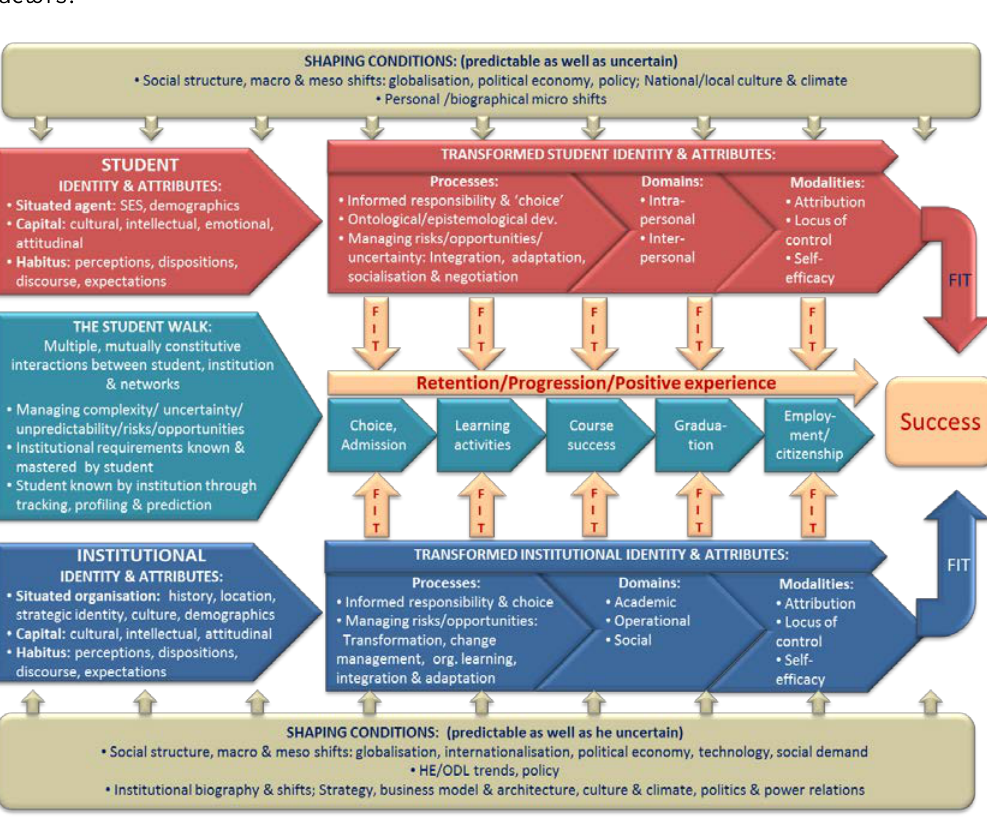
Figure 1 . A socio-critical model for understanding and predicting student success (Subotzky and Prinsloo, 2011, p.